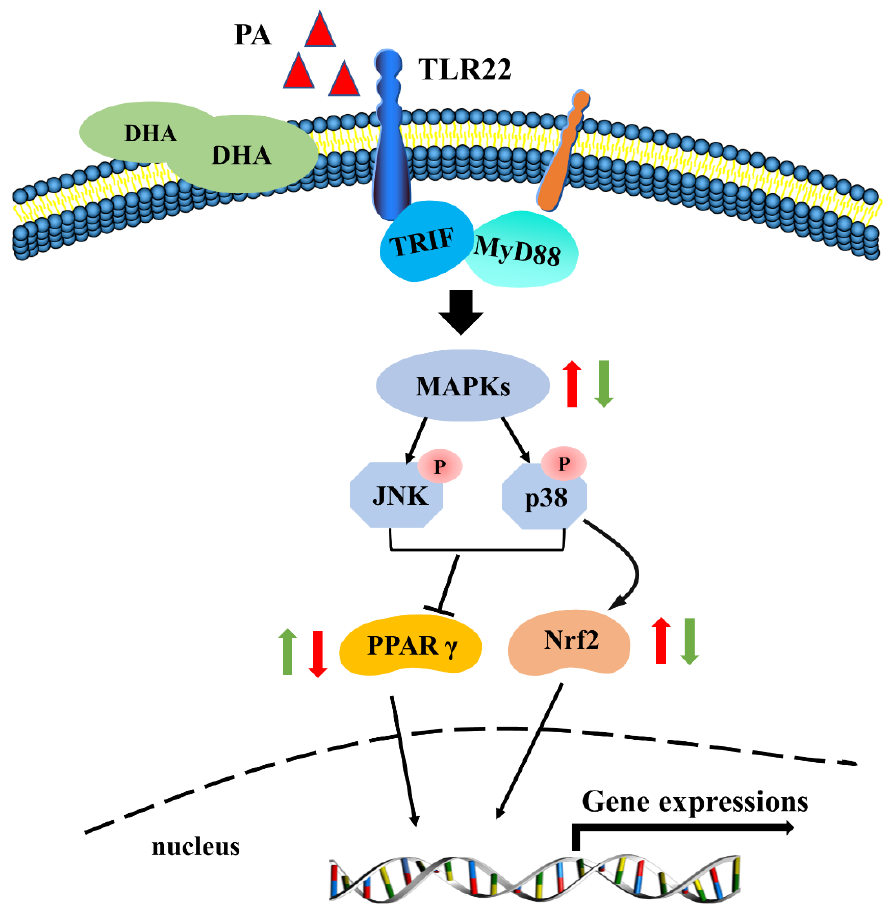
Figure 9. A working model showed the molecular mechanism of the PA-induced inflammatory response and the protective effect of DHA against the inflammation in macrophages of large yellow croaker.